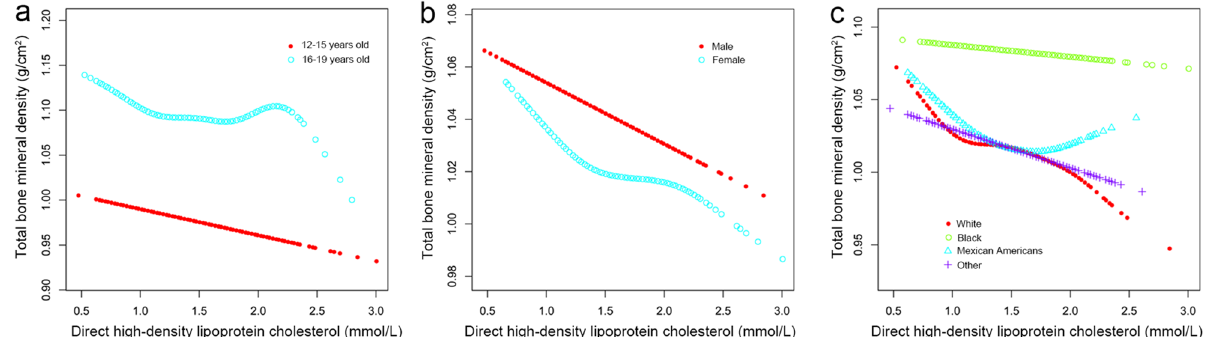
Figure 3. The HDL-C concentration and BMD relationship. ( a ) The illustrated line was stratified by age. ( b ) The illustrated line was stratified by sex. ( c ) The illustrated line was stratified by race/ethnicity.